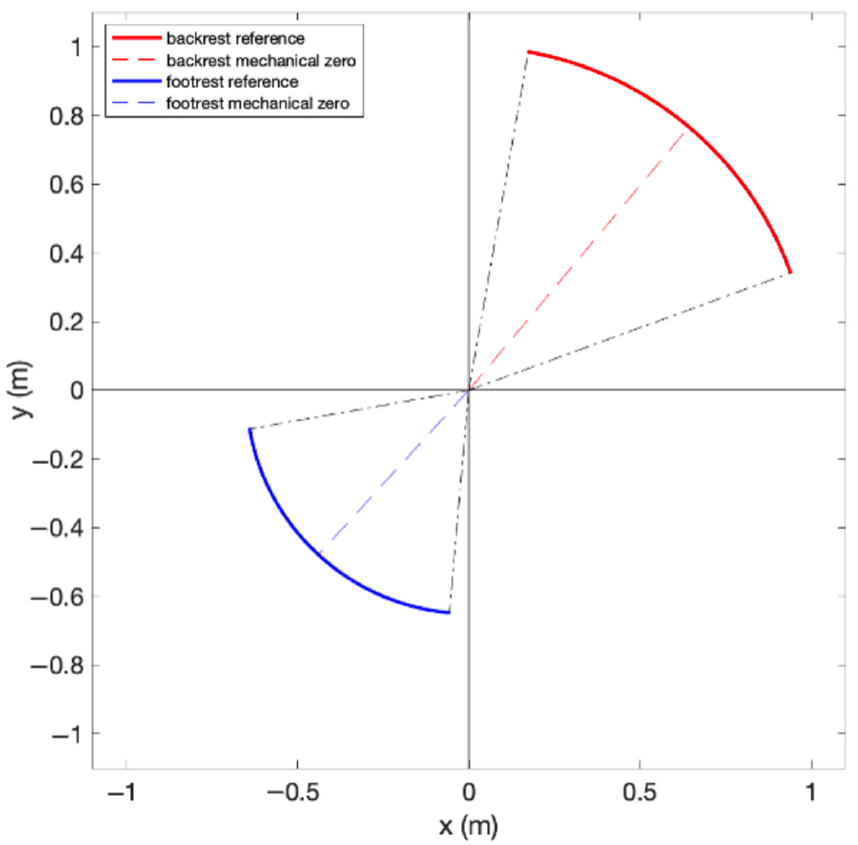
Figure 15. The Cartesian reference trajectories for backrest motion (solid red curve) and footrest motion (solid blue curve).